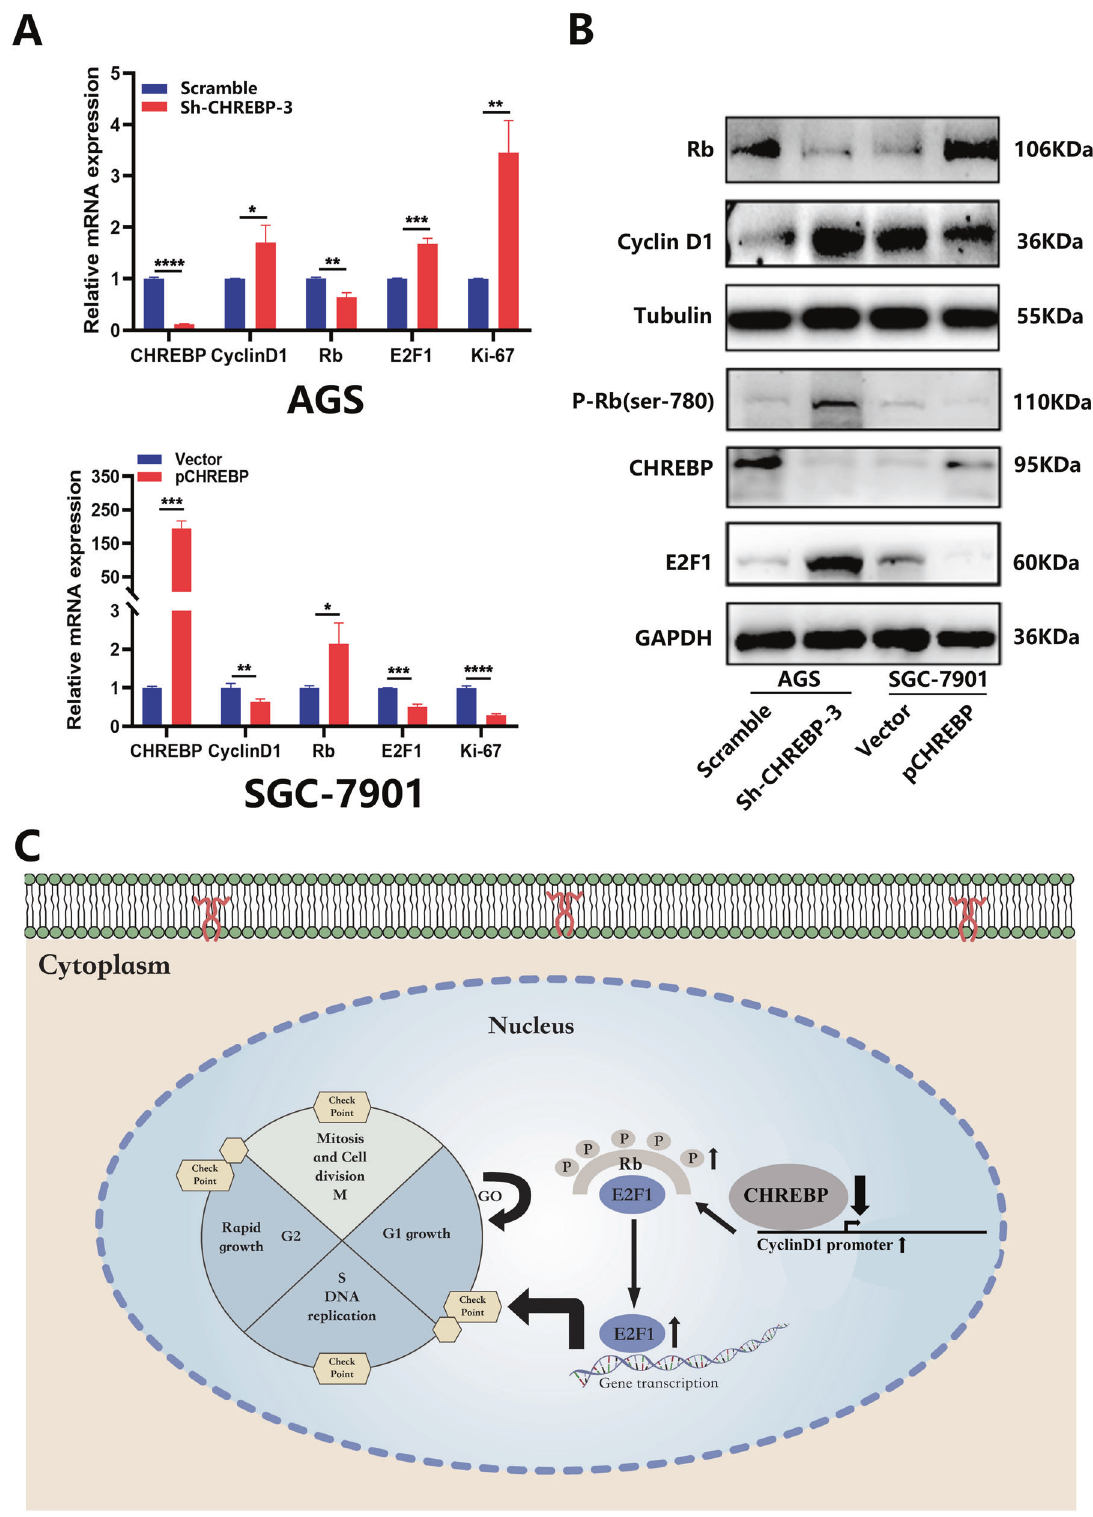
Fig. 7 CHREBP regulates GC growth via the cyclin D1-Rb-E2F1 pathway. A Relative expression levels of CHREBP, cyclin D1, Rb, E2F1, and Ki- 67 were detected in GC cells transfected with scramble, Sh-CHREBP, and an empty vector, p-CHREBP, as determined by qRT – PCR. B WB was used to detect the levels of Rb, cyclin D1, tubulin and phosphorylated Rb (P-Rb), CHREBP, E2F1, and GAPDH in GC cells transfected with scramble, Sh-CHREBP and an empty vector, p-CHREBP. C Concision model of CHREBP in regulating GC progression. The downregulated expression level of CHREBP speci fi cally bound to cyclin D1 promoter, which increased the ability of cyclin D1 to inactivate Rb, leading to the release of E2F1, which could regulate the levels of genes involved in the cell cycle.